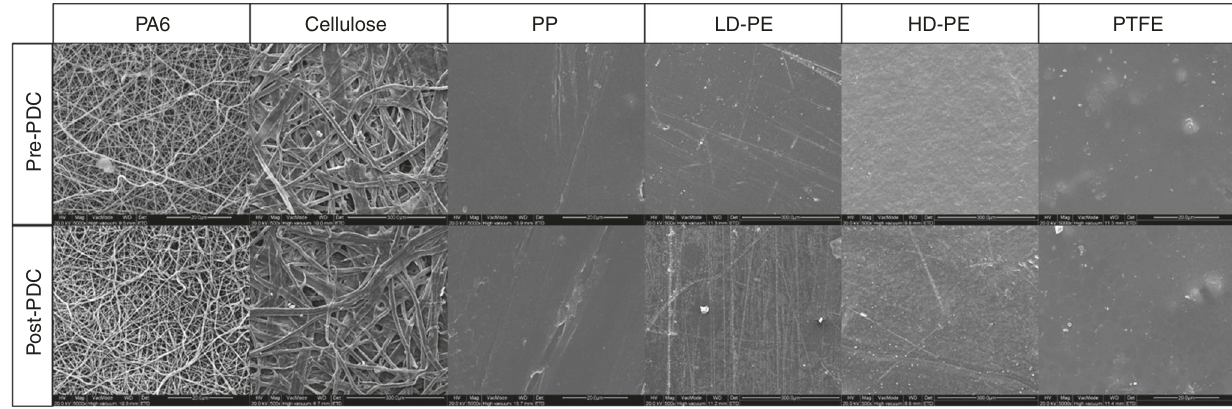
Fig. 10 Overview of SEM images pre- and post-PDC treatment. All materials were coated with DR1-A using the PDC procedure and imaged after puri fi